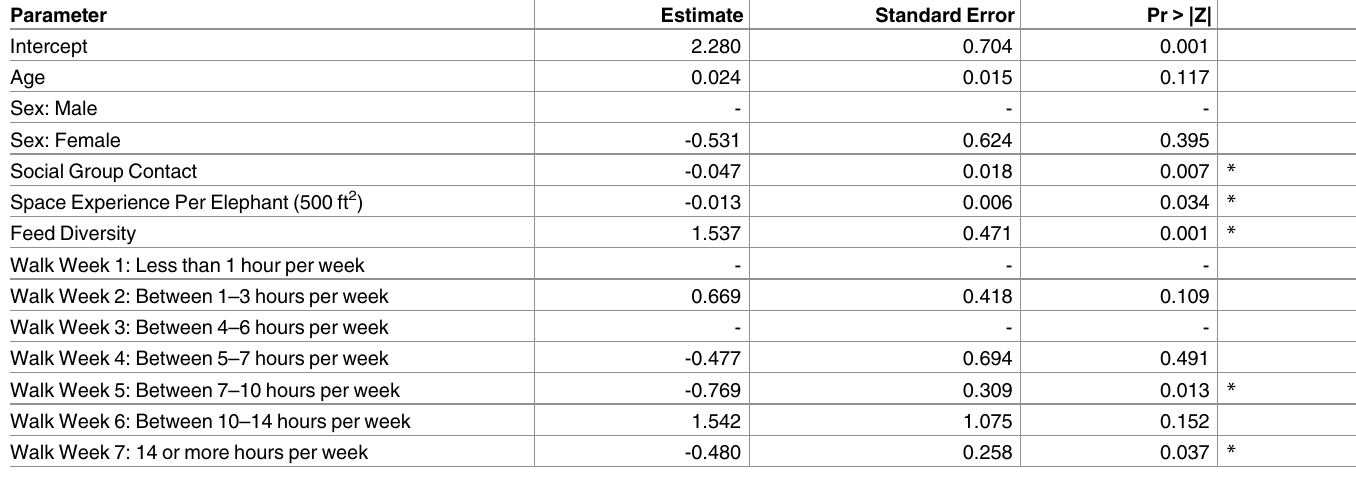
Table 11. Predictive model describing primary variables associated with mean leptin